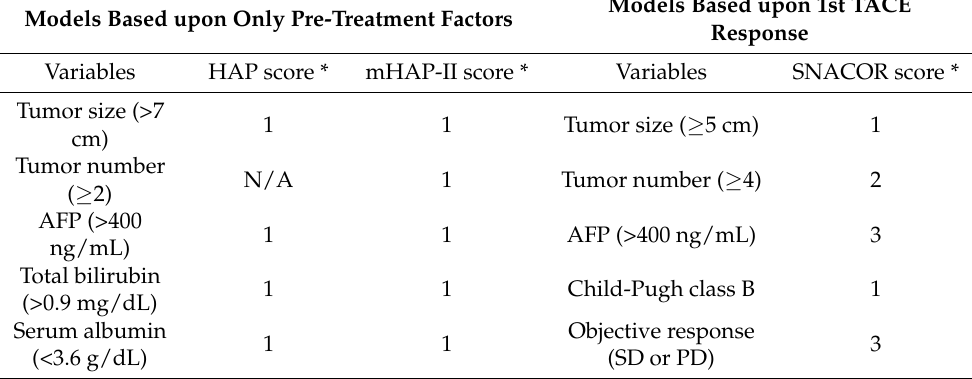
Models Based upon 1st TACE Response